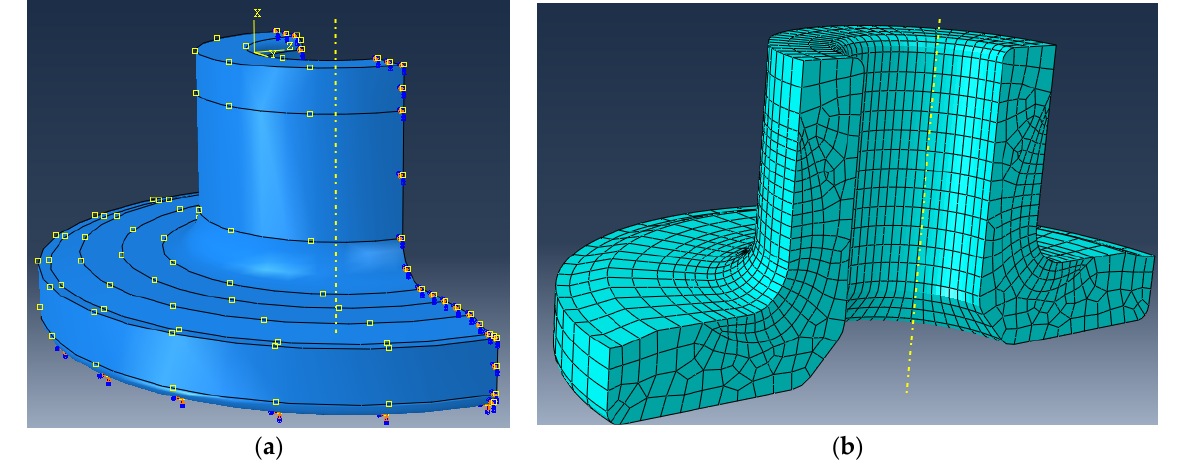
Figure 2. Pressure vessel simulation structure diagram: ( a ) stress load diagram and ( b ) pressure vessel grid simulation model.